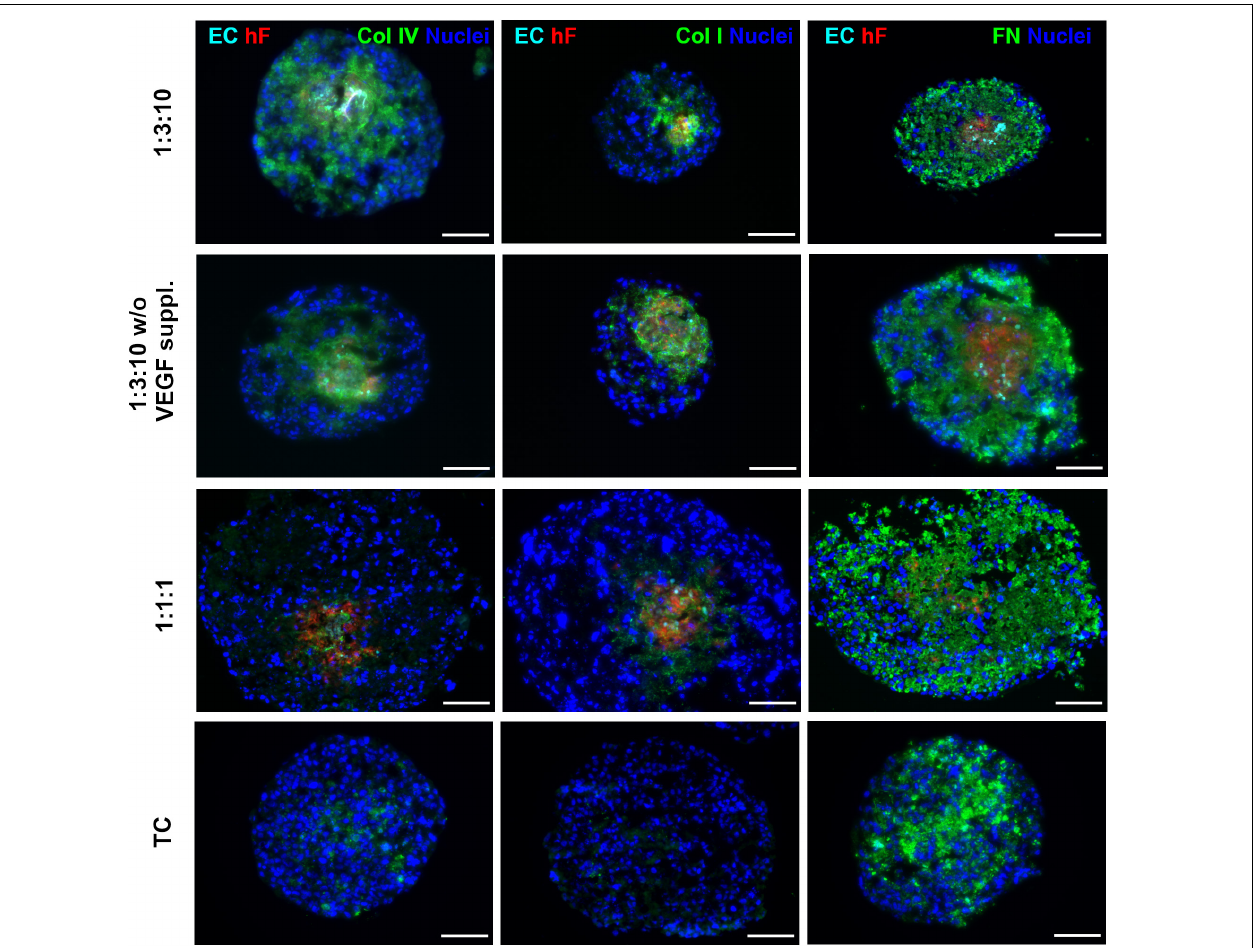
FIGURE 6 | Triple heterotypic spheroids were enriched in ECM proteins. Immunofluorescent detection of collagen IV (Col IV), collagen I (Col I), and fibronectin (FN), all in green; nuclei were labeled with DAPI (blue). Spheroids generated by seeding 6,000 cells per well of HCC1954 breast tumor cells (TC), human dermal fibroblasts, labeled with PKH26 (hF, red); HUVEC, labeled with CellTracker Deep Red (EC, cyan), at a TC:hF:EC ratio of 1:1:1 and 1:3:10. Spheroids were cultured with the standard supplementation of VEGF (0.5 ng/ml), or without (w/o VEGF supplementation) and analyzed at day 30 of culture (2 days of static culture followed by 28 days of agitation-based culture, rotational speed of 100 rpm). Images are representative of the 5–10 spheroids assessed per condition, in each of the three independent experiments performed ( N = 3). Scale bar, 100 µ m.